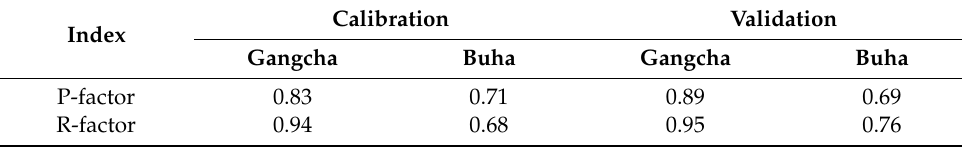
Table 9. Statistical index of model uncertainty